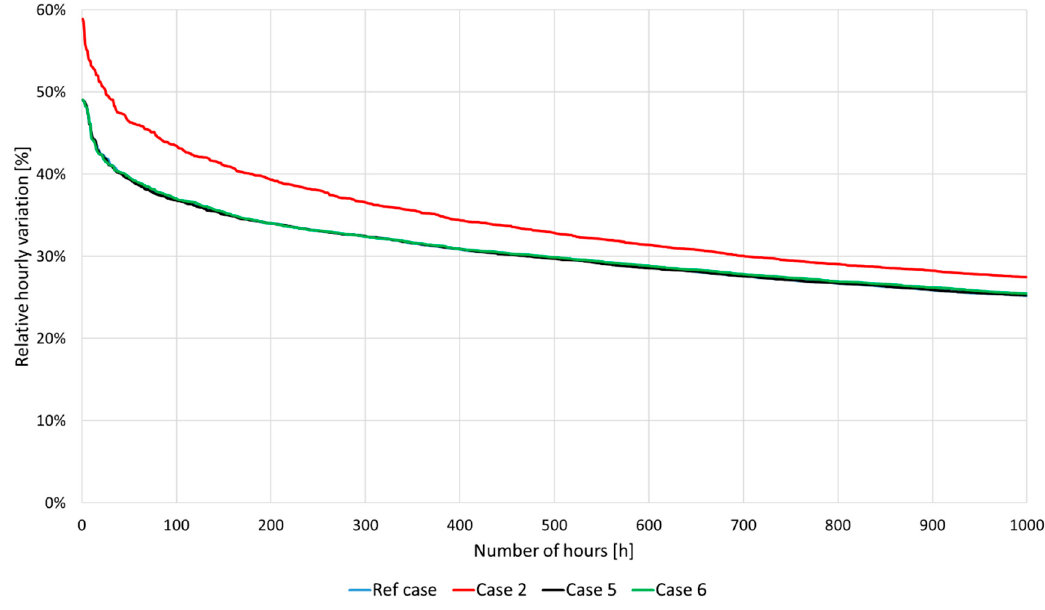
Figure 10. DH system relative hourly variation in the reference case and in the DR Cases 2, 5 and 6.